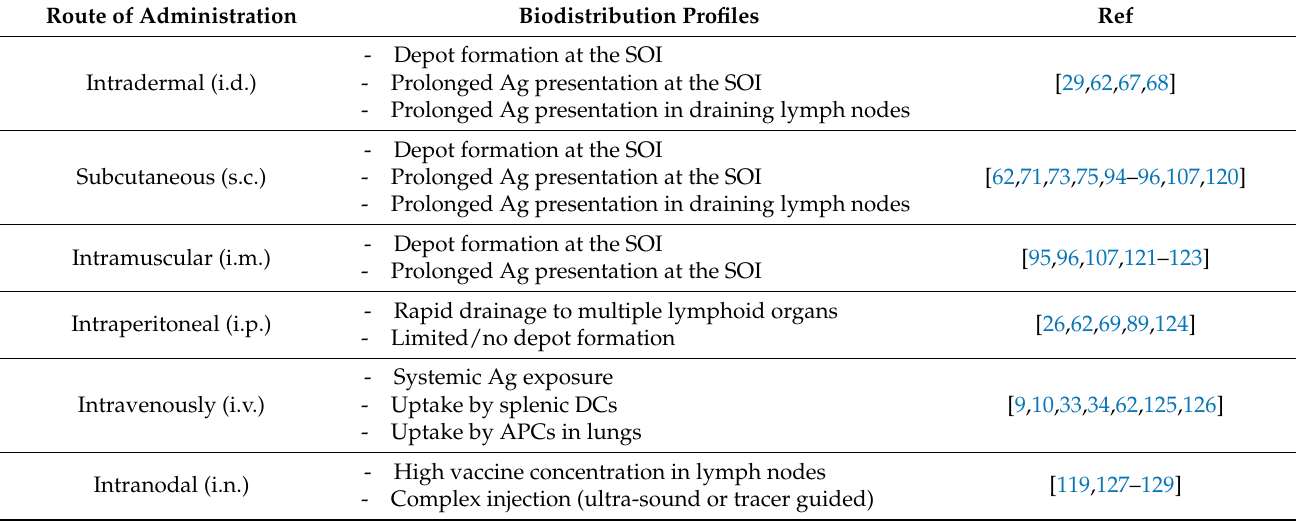
Table 2. Routes of administration for cationic nanoparticulate cancer vaccines with the accompanied observed biodistri- bution. A limited number of studies describe i.n. administration of cationic nanoparticles, but not with cancer vaccines. Nonetheless, the i.n. route with cationic nanoparticulate formulations with peptide and mRNA have been included in the table.